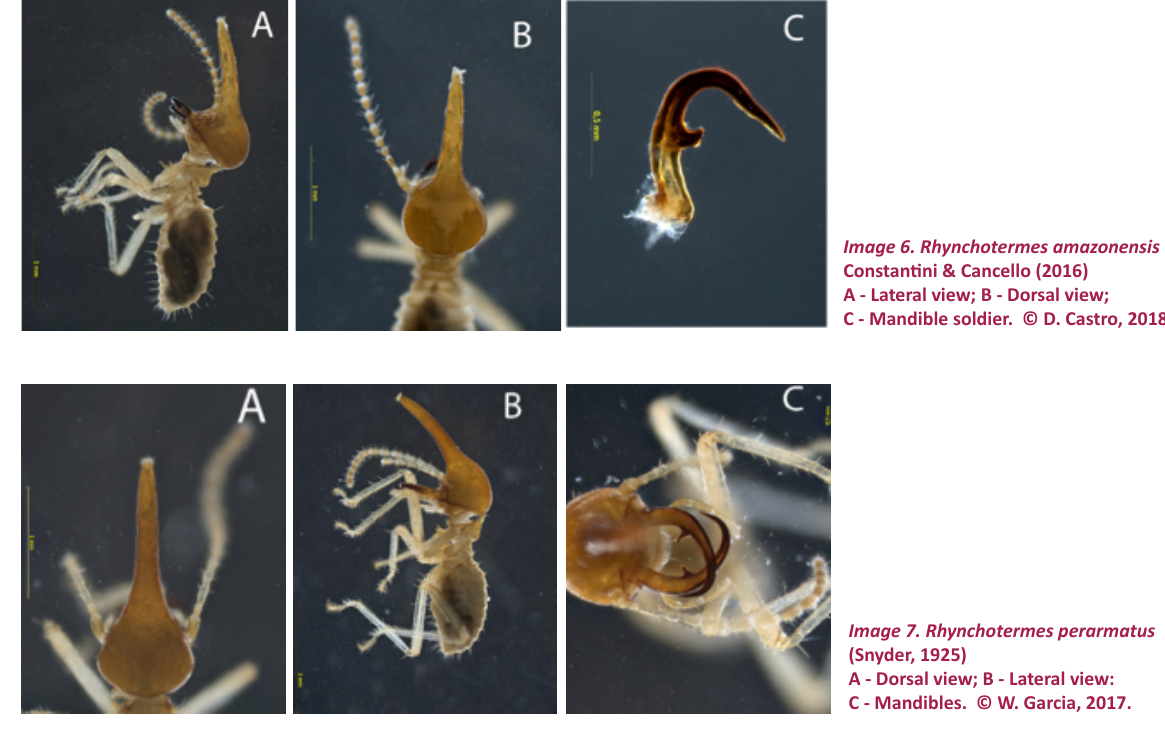
Image 7. Rhynchotermes perarmatus (Snyder,